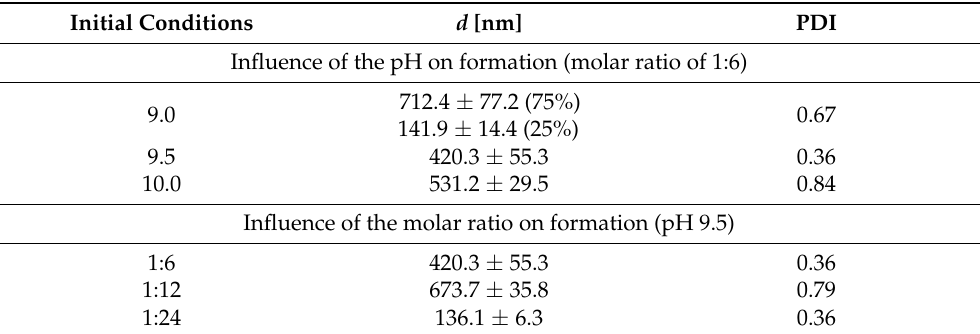
Table 3. Particle size ( d ) and polydispersity index (PDI) of G4.0 PAMAM-DOX complexes at differ- ent pHs and molar ratios of formation after dialysis, determined using the DLS method (analysis by